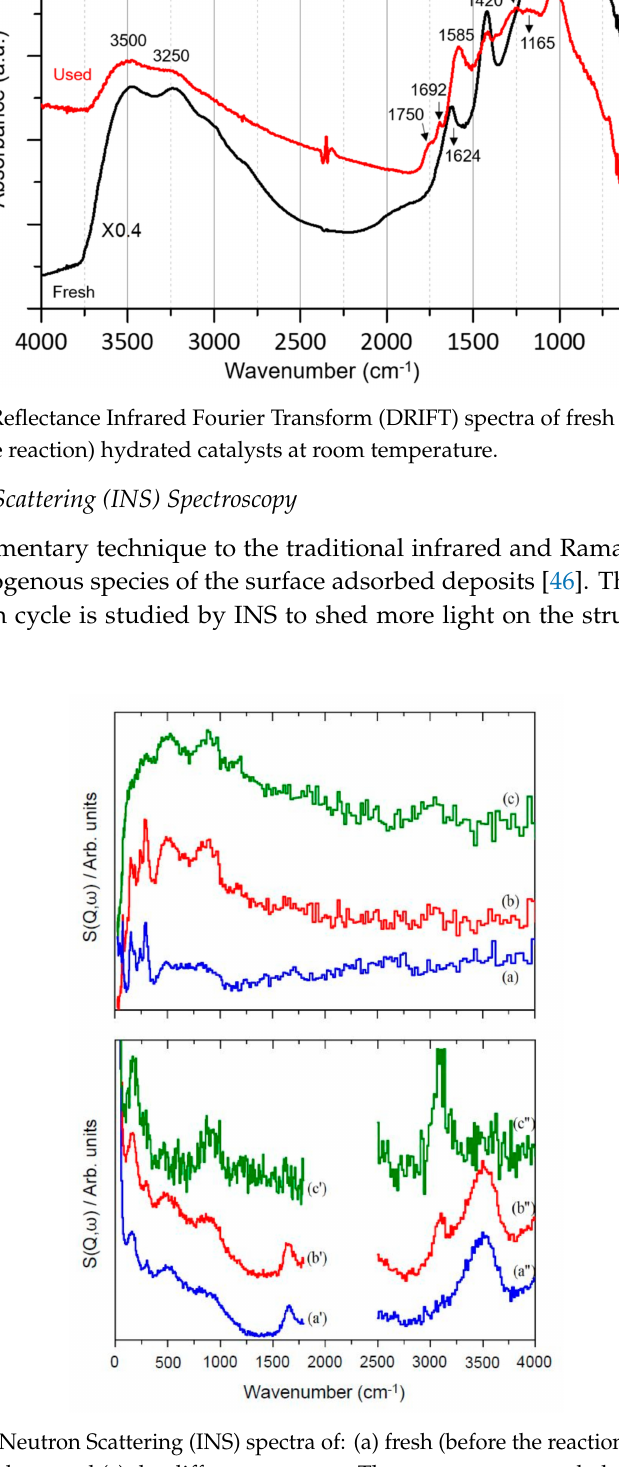
Figure 5. Inelastic Neutron Scattering (INS) spectra of: (a) fresh (before the reaction), (b) used (after the reaction cycle) catalysts and (c) the di ff erence spectra. The top set was recorded on TOSCA, with the fresh catalyst recorded immediately after drying in vacuum at 110 ◦ C. The lower set were recorded with MAPS using incident energies of 2000 cm − 1 (a (cid:48) , b (cid:48) , c) and 5200 cm − 1 (a”, b”, c”). The fresh